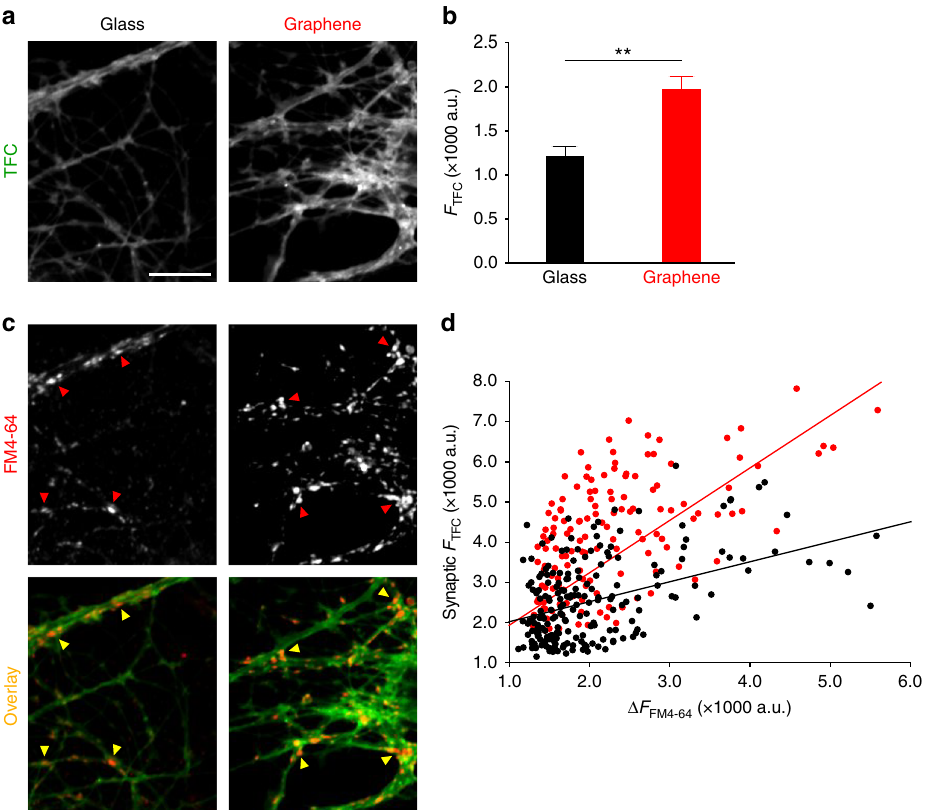
Fig. 4 Graphene increases synaptic membrane cholesterol. a Sample images of TopFluor-Cholesterol (TFC) staining of neurons. Scale bar, 10 μ m. b Average TFC staining intensity of threshold de fi ned ROIs ( n = 9 FOVs, N = 3 batches, ** p < 0.01, two-tailed t -test). c Sample images of FM4-64 staining of neurons. Same scale bar as a . Arrowheads indicate examples of synaptic boutons de fi ned by FM4-64 labeling. d Overlay of a and b , arrowheads from b . e Δ FM 4-64 fl uorescence intensity (see Methods) vs. TFC intensity in FM4-64-de fi ned synaptic boutons (both n = 9 FOVs, N = 3 batches; p < 0.05, two- tailed t -test). Linear regression fi ttings indicate correlation for graphene ( F TFC = 1.2083 × F FM4-64 − 253.29 a.u., Pearson correlation coef fi cient = 0.6629, red solid line) and glass ( F TFC = 0.6273 × F FM4-64 + 837.85 a.u., Pearson correlation coef fi cient = 0.5698, black solid line). Error bars are